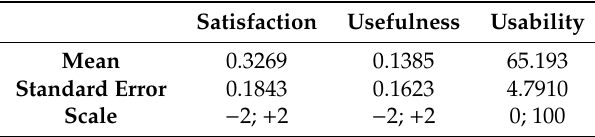
Table 3. Mean and standard error of Satisfaction, Usefulness and Usability.